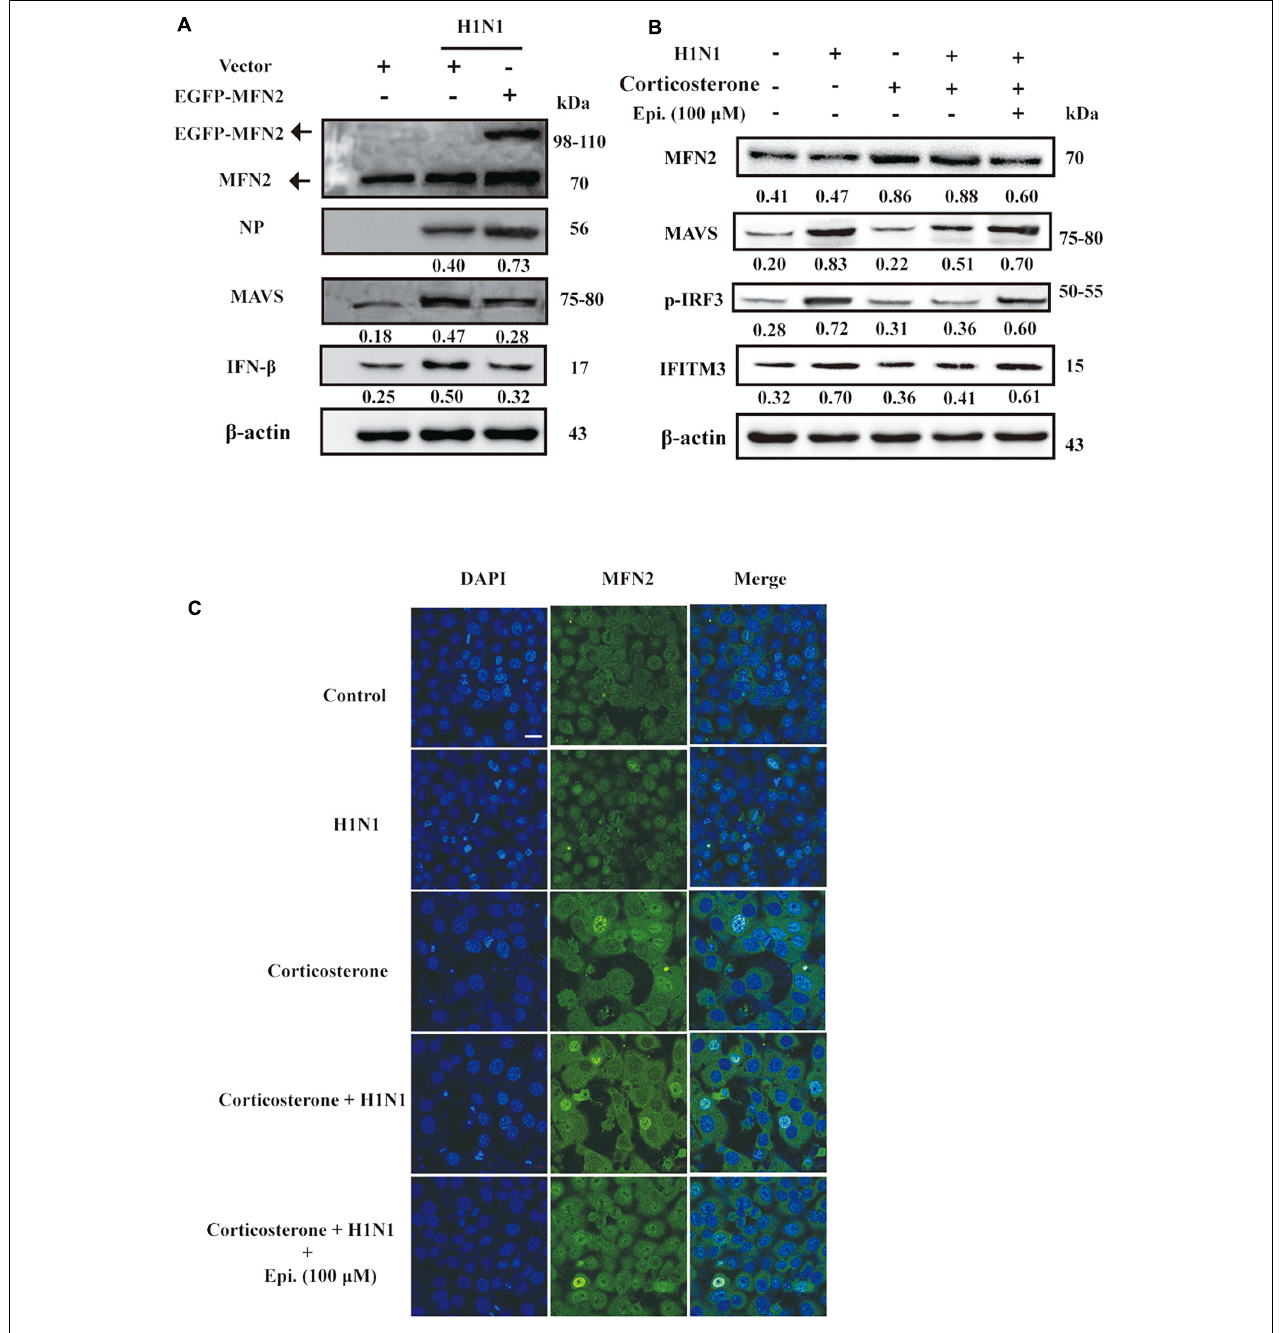
FIGURE 6 | MFN2 was involved in the regulation of IFN- β production by epigoitrin in stress cell model. (A) Effects of EGFP-MFN2 overexpression on H1N1 infection. (B) The levels of protein expression by the MFN2, MAVS, p-IRF3, and IFITM3 gene relative to the level of β -actin expression were determined using the respective antibodies. (C) Representative fluorescence images showing the levels of MFN2 protein expression. Bar = 20 µ m.